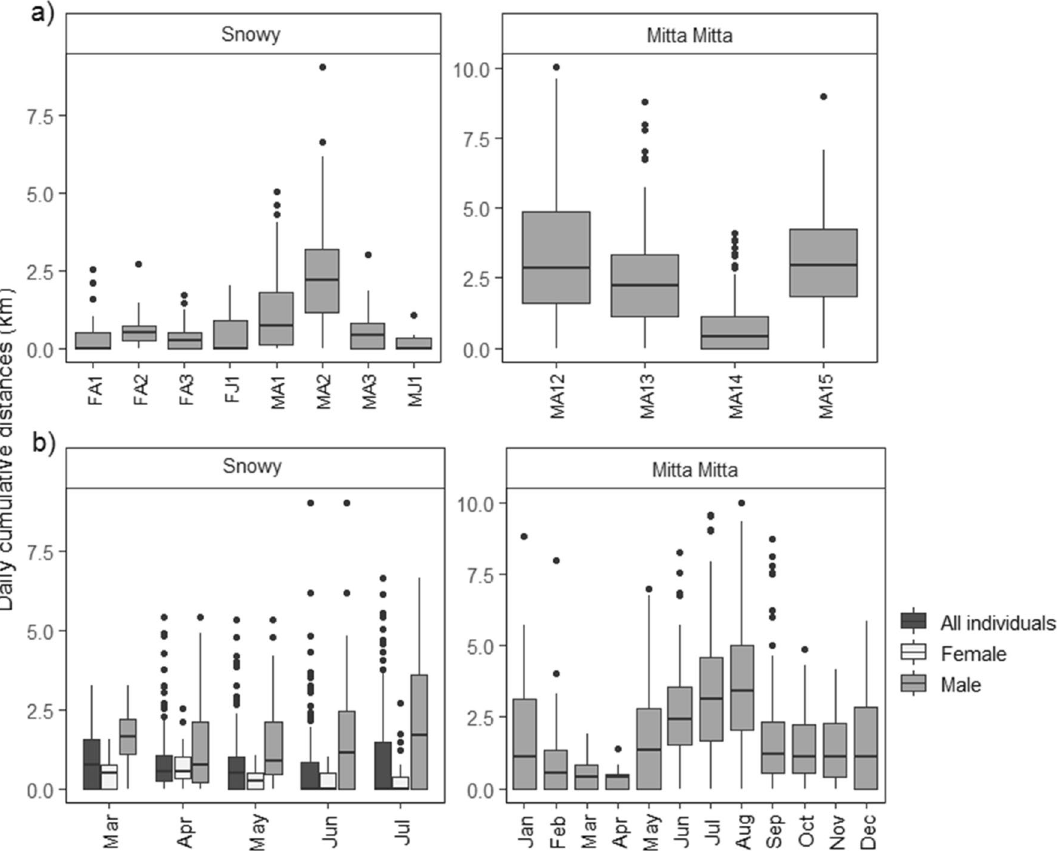
Figure 3. Daily cumulative movements (km) for platypuses on the Snowy River and Mitta Mitta River for ( a ) individuals across the entire study period and ( b ) monthly variation between On the Mitta Mitta River, the daily average range of the four males was 1.0 ± 0.46 km, with platypuses utilis- ing 1.84–8.45 km of river over the 12-month period. MA12 and MA13 had far greater movements upstream and downstream, compared to MA14 and MA15 (Fig. 2a; Table 1). MA12 had the highest average daily range (1.39 ± 1.00 km), while MA13 had the highest maximum daily range (3.50 km) and used a linear river range of 8.45 km during the 12-month period. Range movements were significantly higher in June (1.26 ± 0.75 km), July (1.46 ± 0.91 km), and August (1.37 ± 0.75 km), compared with all other months ( P ≤ 0.001; Fig. 2b, Appendix 2). Based on GAMM models, daily range movements had a significant positive association with number of detec- tions (F = 48.919, P < 0.001, Appendix 2), and flow (F = 11.899, P < 0.001, Appendix 2), increasing towards 1900 ML/d, but decreasing with greater flow rates. No association were detected with rainfall (F = 0.946, P = 0.331, Appendix 2). Cumulative movements. On the Snowy River, average cumulative daily movements were 0.87 ± 1.18 km. MA2 had the highest average (2.37 ± 1.57 km) and maximum (9.04 km) daily cumulative movements and trav- elled 335.30 km over 155 days (Fig. 3a). Adult males had significantly higher cumulative daily movements com- pared to females for all months ( P ≤ 0.004) except April ( z = − 0.582, P = 0.560; Fig. 3b, Appendix 3). Cumulative daily movements of females were higher in April (0.65 ± 0.49 km) compared to all months ( P ≤ 0.017) and signifi- cantly lower in June (0.19 ± 0.29 km) compared to all months ( P ≤ 0.001) except July (0.27 ± 0.50 km, z = 1.400, P = 0.162). Male cumulative movements were significantly higher in July (2.03 ± 1.99 km) compared to April (1.30 ± 1.14 km, z = − 2.575, P = 0.010), and marginally higher than in March, May, and June ( P ≤ 0.085; Appendix 3). Based GAMM models, the number of detections was positively associated with range up to 100 detections but declined thereafter (F = 21.398, P < 0.001), a negative association with flow (F = 4.254, P = 0.029), and no associa- tion with rainfall (F = 0.052, P = 0.820), (Appendix 3). On the Mitta Mitta River, average cumulative daily movements were 2.43 ± 1.22 km. MA12 had the highest average (3.48 ± 2.46 km) and maximum (9.61 km) daily cumulative movements and travelled 779.14 km over the 12-month period (Fig. 3a). Cumulative movements were significantly higher in June (2.75 ± 1.75 km), July (3.44 ± 2.23 km), and August (3.73 ± 2.12 km), compared with all other months ( P ≤ 0.001; Fig. 3b, Appendix 3). Based on GAMM models, cumulative daily movements were significantly associated with number of detections (F = 61.704, P < 0.001). Cumulative daily movements had a positive association with flow, increasing towards 1900 ML/d, before a slight decrease (F = 24.124, P < 0.001) and a significant positive association with rainfall (F = 5.235, P = 0.022; Appendix 3).